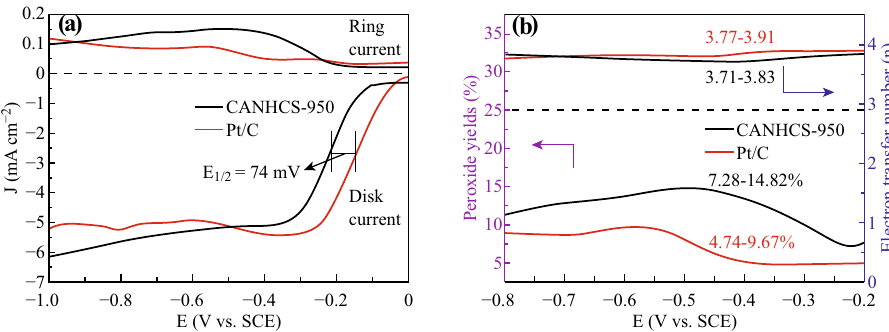
Fig. 9 a Rotating ring-disk electrode (RRDE) voltammograms for CANHCS-950 and Pt/C in O 2 -saturated 0.1 M KOH electrolyte at a rotation rate of 1600 rpm with a ring potential at 0.2 V (vs. SCE) and b number of electrons transferred and peroxide yields of CANHCS-950 and Pt/C in O 2 -saturated 0.1 M KOH electrolyte